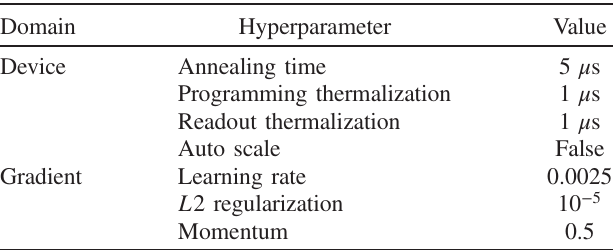
TABLE III. Settings used in all the experiments except those in Sec. V C, where gradient hyperparameters were